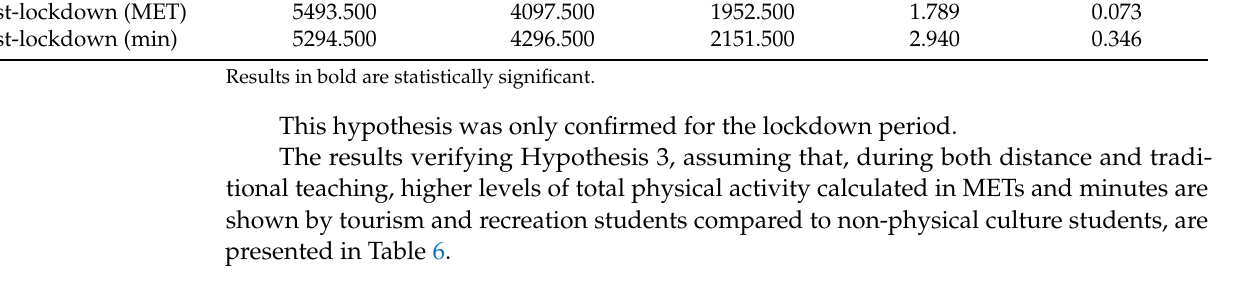
Table 6. Comparison of the amount of physical activity of TR and NPC students in the. Lockdown and post-lockdown period (U Mann–Whitney test).